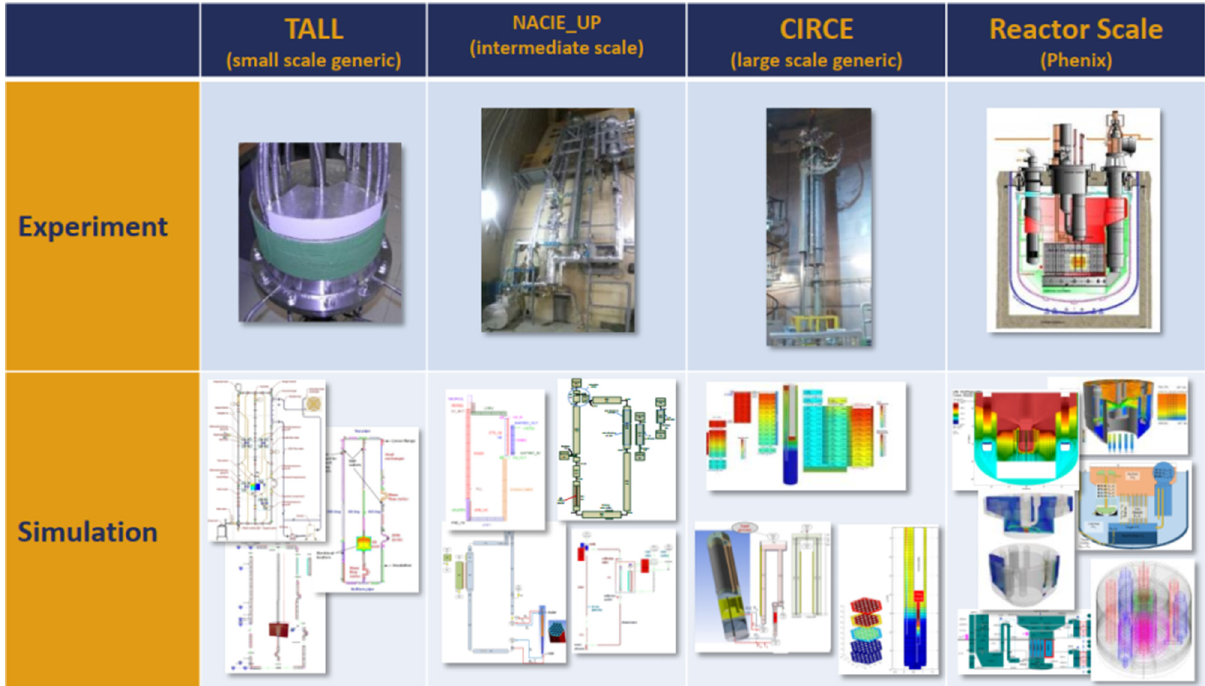
Fig. 7. Overview of system scale experiments and